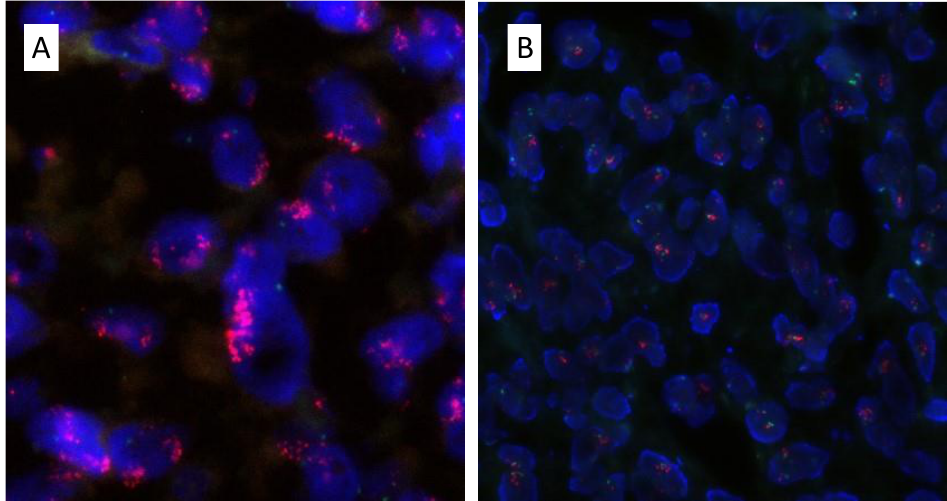
Figure 4. MDM2 gene amplification by FISH (in red signals). ( A ) MDM2 gene amplification in case 1 (40×). ( B ) MDM2 gene amplification in case 3